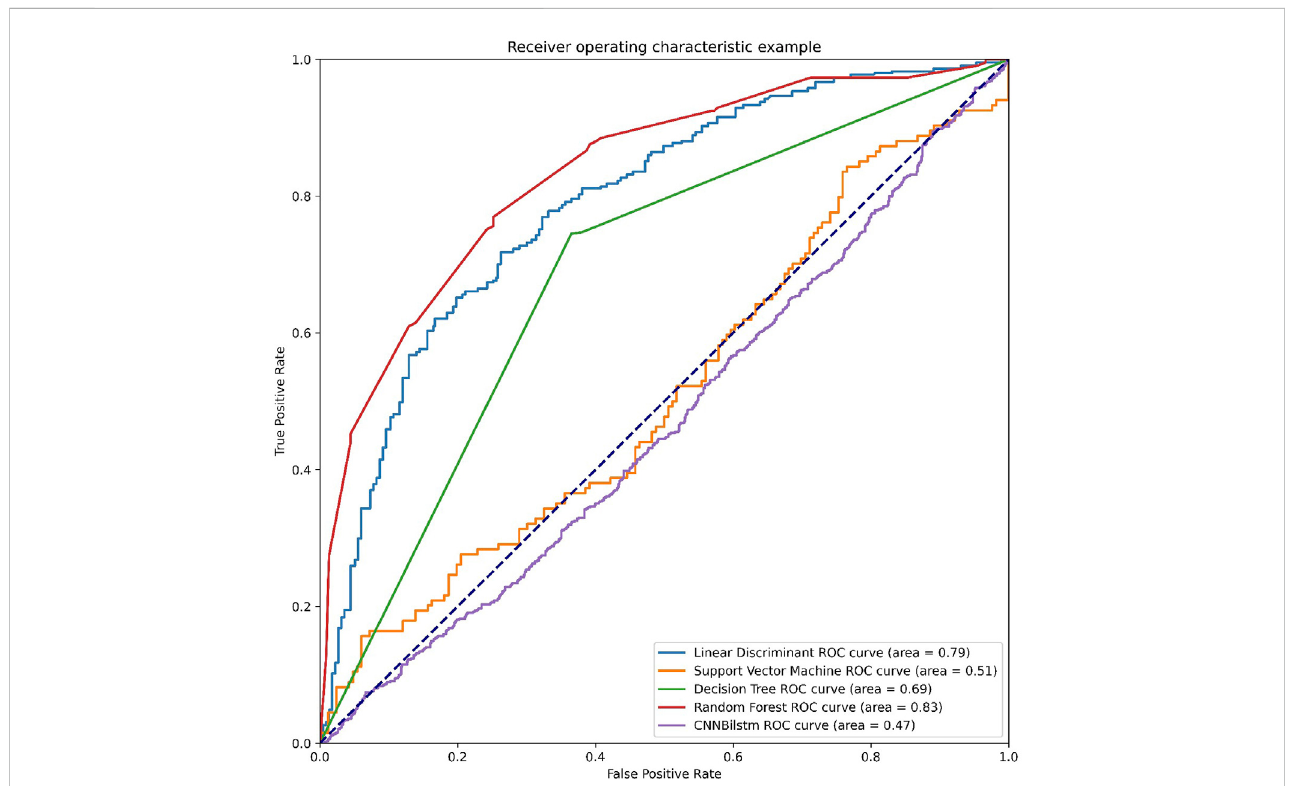
FIGURE 3 The ROC curves of AAC feature. Note: LD means the linear discriminant classi fi er. SVM means the support vector machine. DT means the decision tree. RF means the random forest and CNNBilstm mean convolution neural network with Bi-Long Short Term